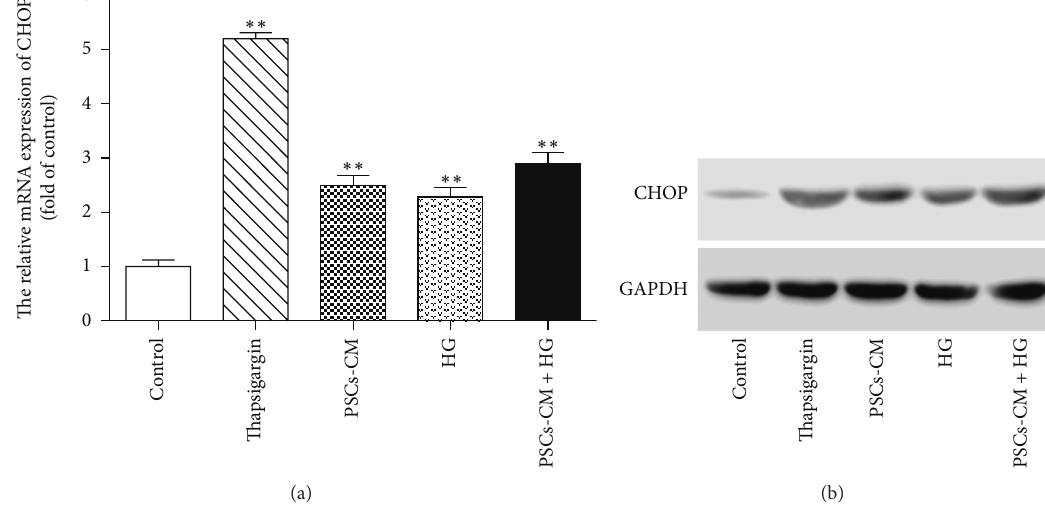
Figure 6: PSCs-CM induces ER-stress in INS-1 cells in vitro . CHOP mRNA (a) and protein (b) expression were up-regulated in INS-1 cells exposed for 24 h to PSCs-CM or HG alone and, again, their effects were